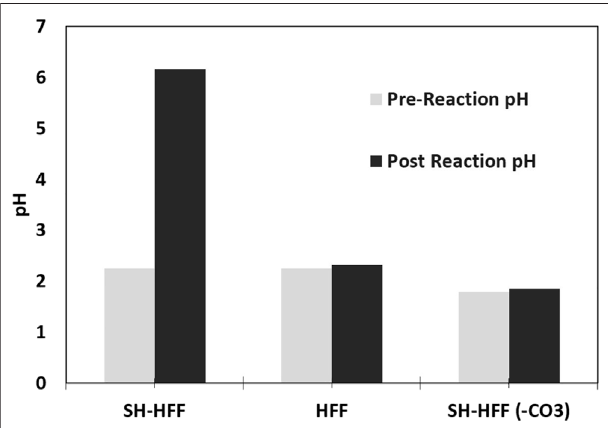
FIGURE 1 | pH measured immediately before reaction vs post-reaction pH for each